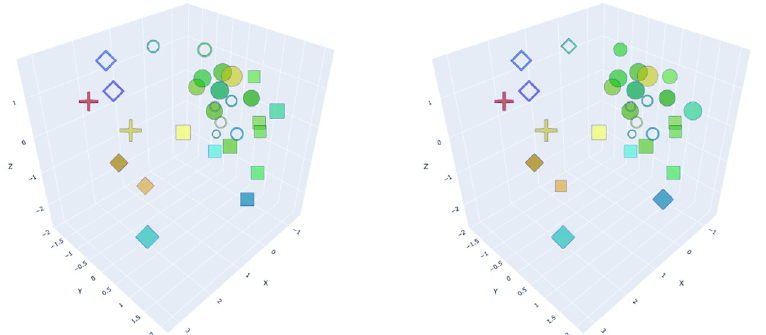
Fig 5. Agglomeration coefficients increased percentage for the last 10